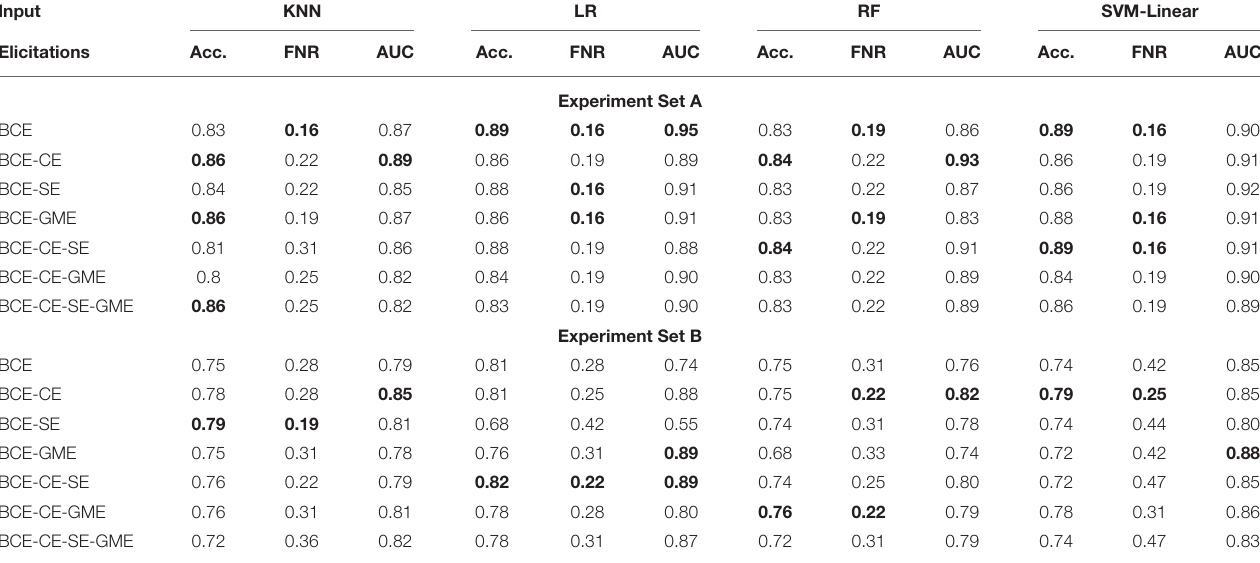
TABLE 3 | Performance analysis of crowdsourcing based ML methods for balanced dataset. Input